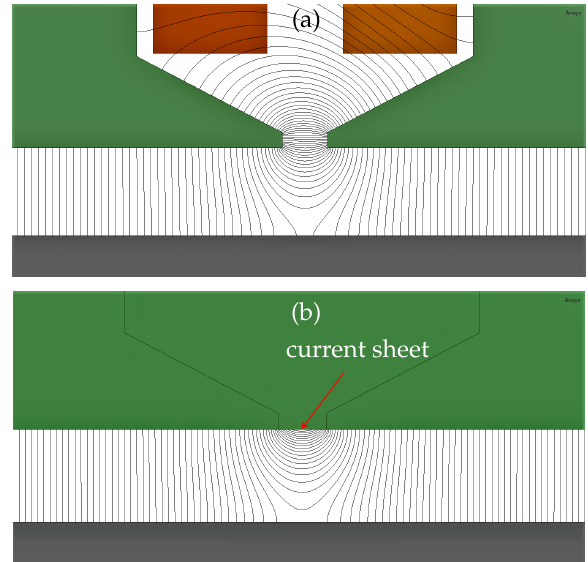
Figure 5. ( a ) Flux lines produced by two rectangular active sides whose total m.m.f. is M s (slot opening b so = 6 mm). ( b ) Flux lines produced by a horizontal current sheet of length equal to the slot opening b cs = b so = 6 mm energized by a current I = M s